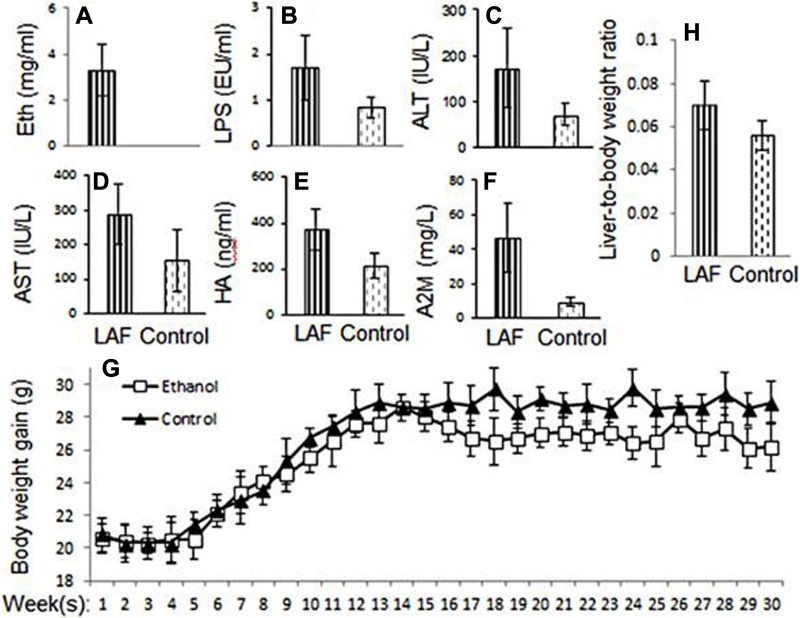
Animal model data and plasma biochemical changes. Plasma ethanol levels are persistently greater in ethanol-fed mice (A). The inflammatory mediator LPS is significantly elevated in ethanol-fed mice (B). Plasma ALT (C) and AST (D) levels are significantly increased in ethanol-fed mice compared to control mice. Serum liver fibrosis parameters HA (E) and alpha-2-macroglobulin (F) are elevated in ethanol-fed mice compared to control mice. There is a difference in liver-to-body weight ratio (H) between ethanol-fed and control animals but no significant difference in body weight gain (G). ALT indicates alanine aminotransferase; AST, aspartate aminotransferase; HA, hyaluronic acid; LPS, lipopolysaccharides.